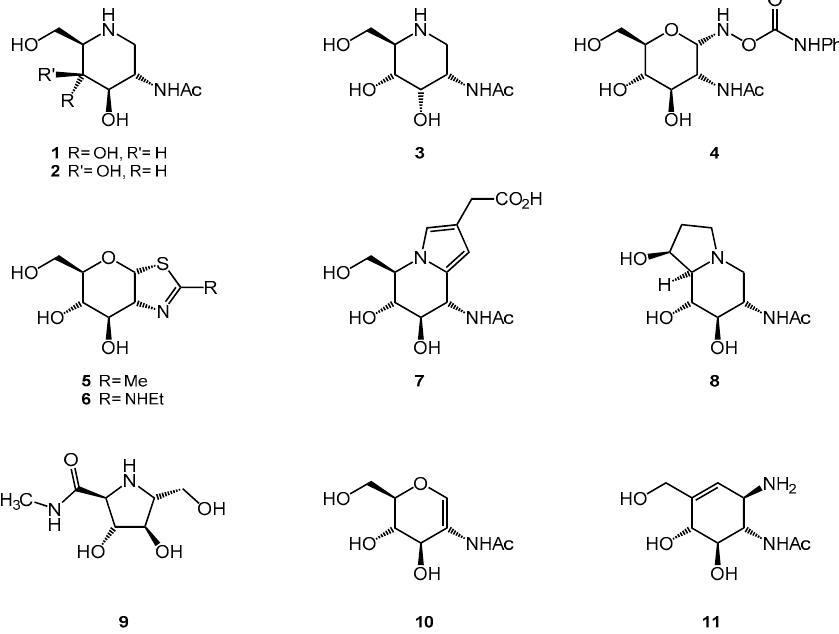
Figure 1. Examples of established as well as recently reported N -acetyl- D -hexosaminidase